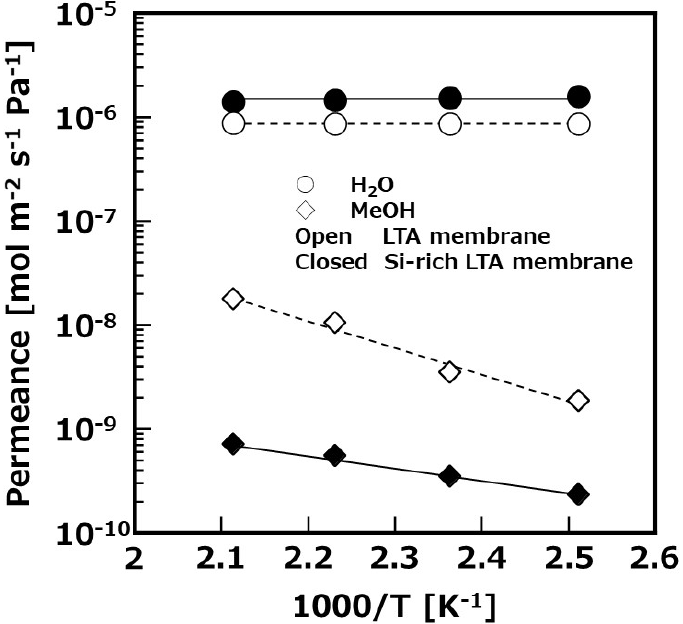
Figure 3. Temperature dependence of vapor permeation through synthesized Si-rich LTA mem- brane at 398–473 K in a 10/90 wt% vapor of H 2 O/MeOH.